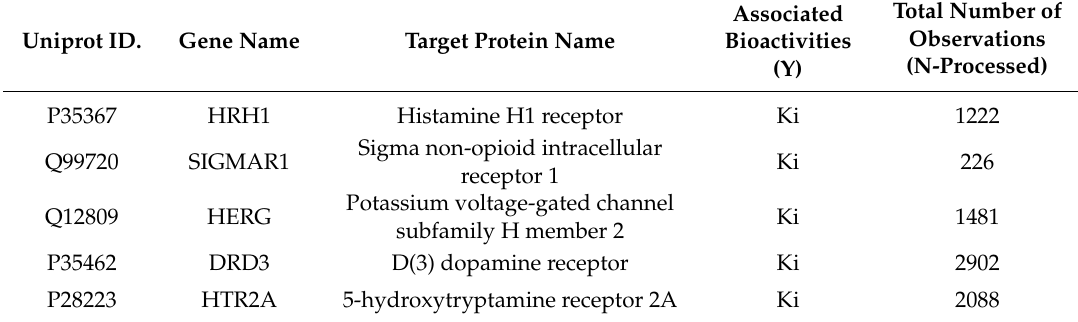
Table 1. Data set